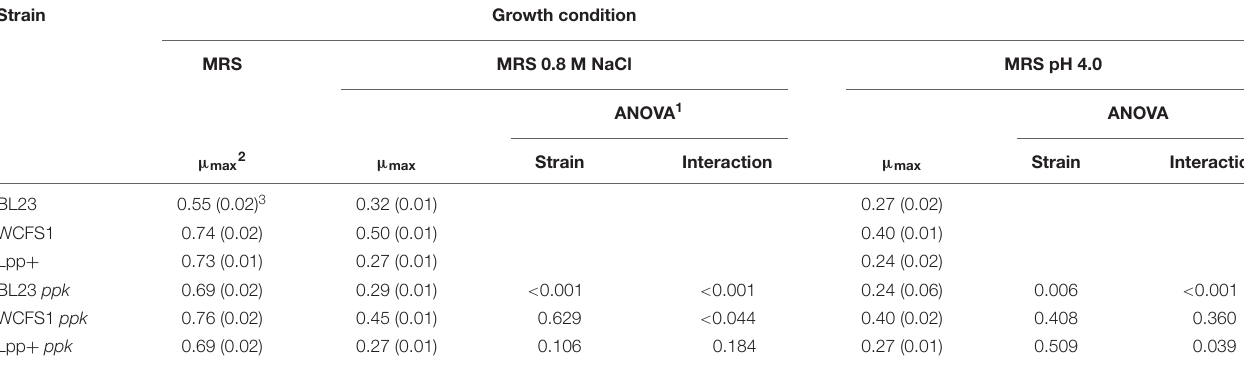
TABLE 2 | Maximal growth rate values and pairwise two way ANOVA at different growth conditions.